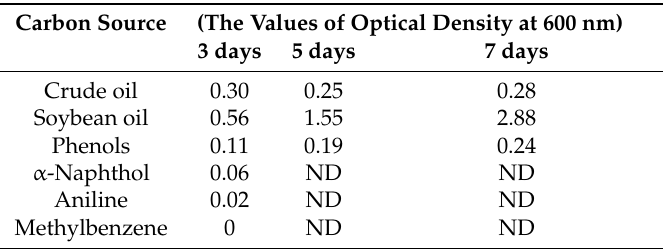
Table 2. Growth of the H9-3 strain in several carbon sources for 7 days.